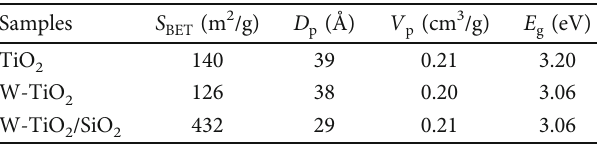
Table 1: Textural data and E ∗ /SiO O 2 2